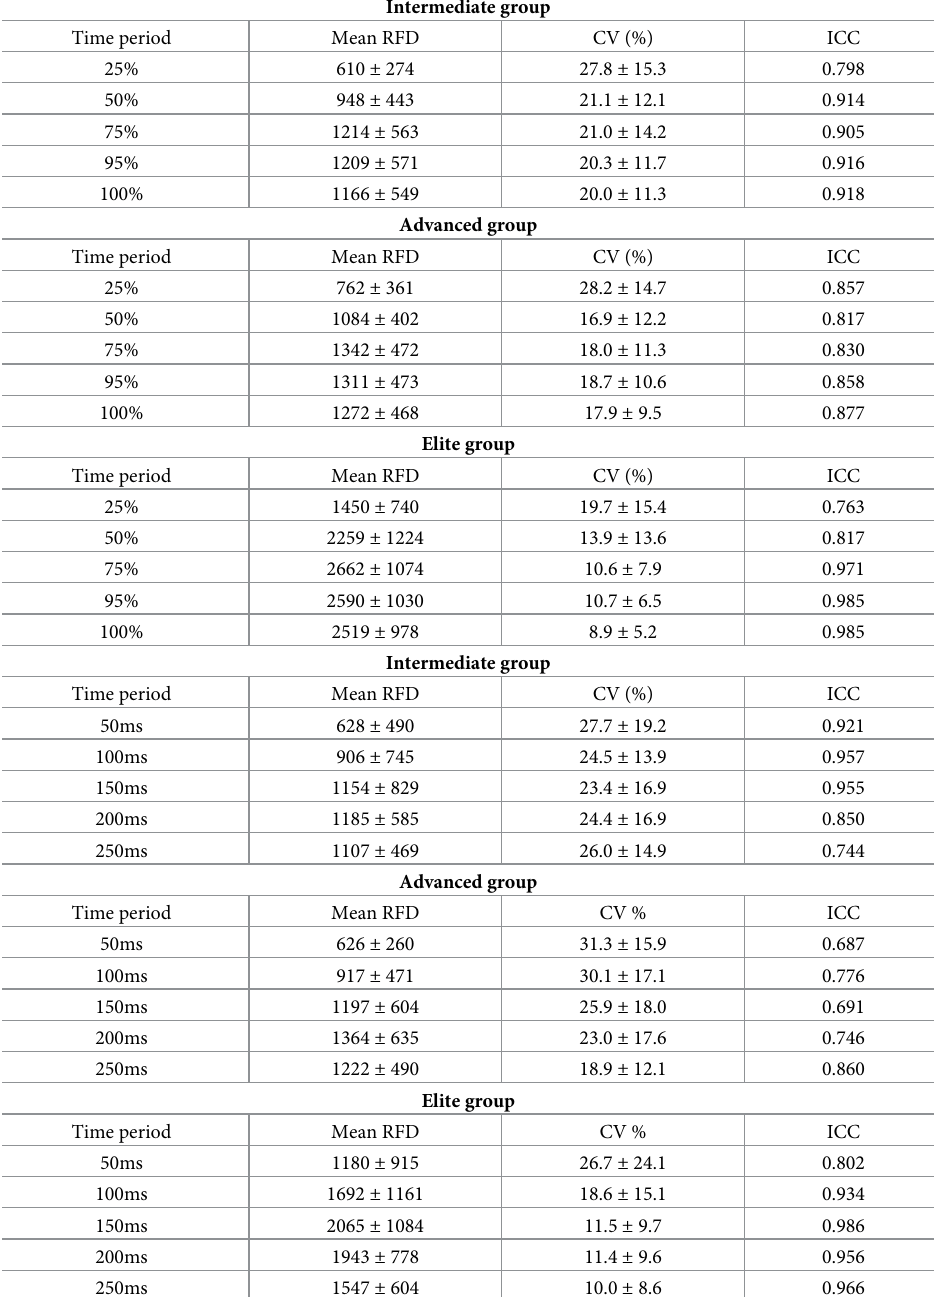
Table 2. a. The mean rate of force development (Newton × s -1 ) from the three attempts for each group using the relative time periods with the mean rate of force development and the intra-class correlation (ICC) and coefficient of variation (CV) between the three attempts. b. The mean rate of force development (Newton × s -1 ) from the three attempts for each group using the absolute time periods with the mean rate of force development and the intra-class correlation (ICC) and coefficient of variation (CV) between the three